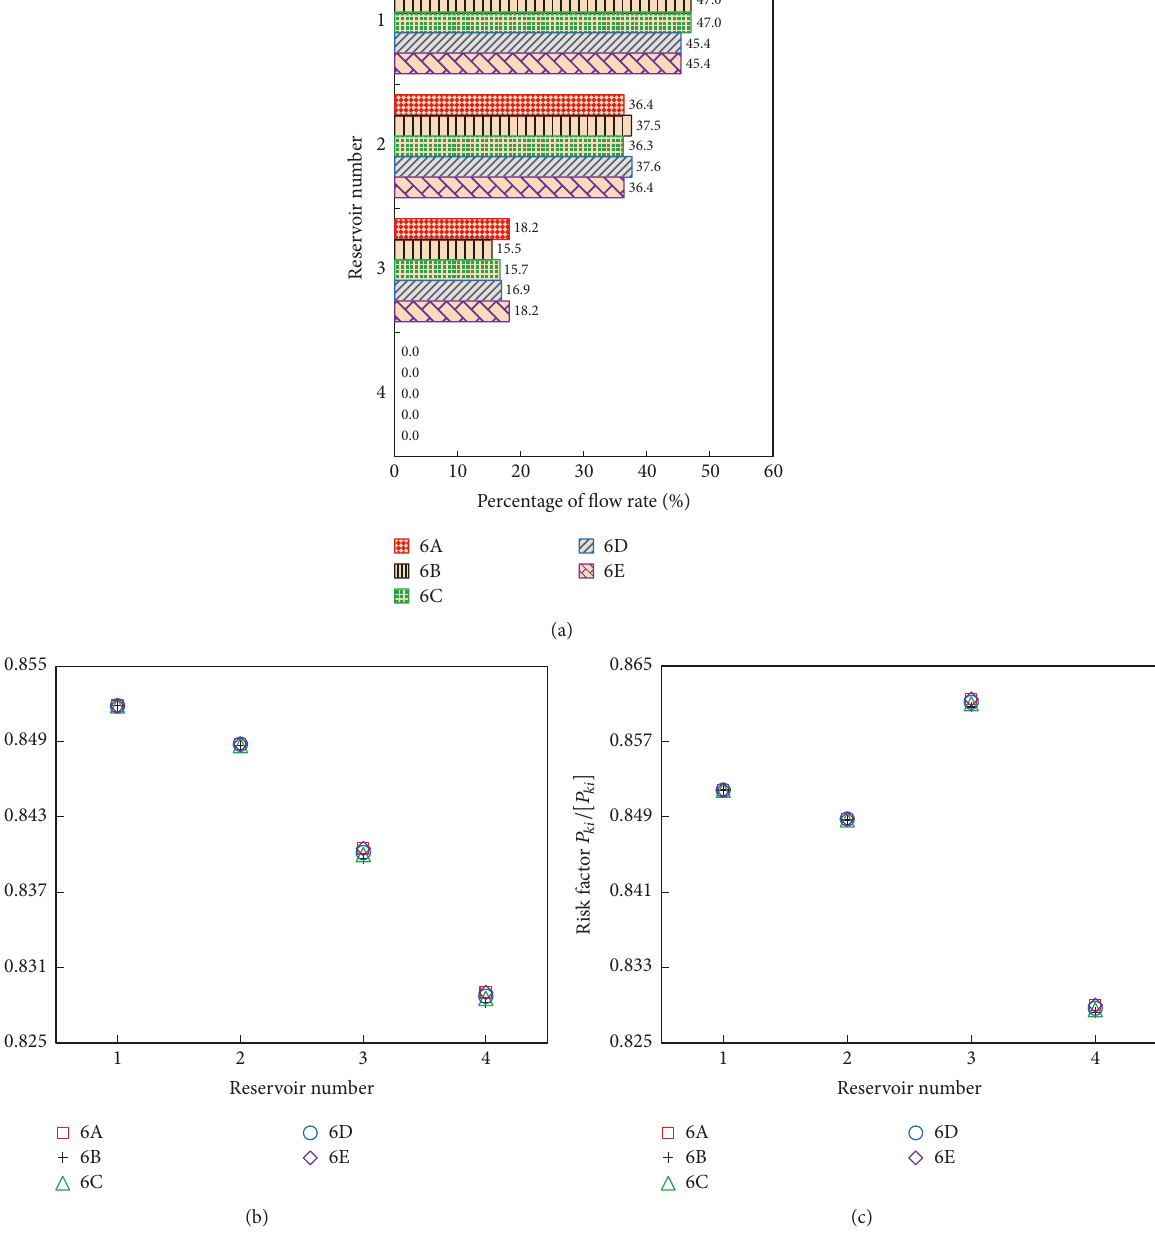
notably greater than that of the lower reservoirs. Because the extent of the variation in each reservoir was different, the CR could shift. This result demonstrates that the injection pressure controls the overall risk level of the reservoir and the flow-rate distribution among the reservoirs can control the position of the CR. The CO 2 injection temperature had a similar effect as the injection flow rate, but the fluid injection temperature had no effect on the position of the